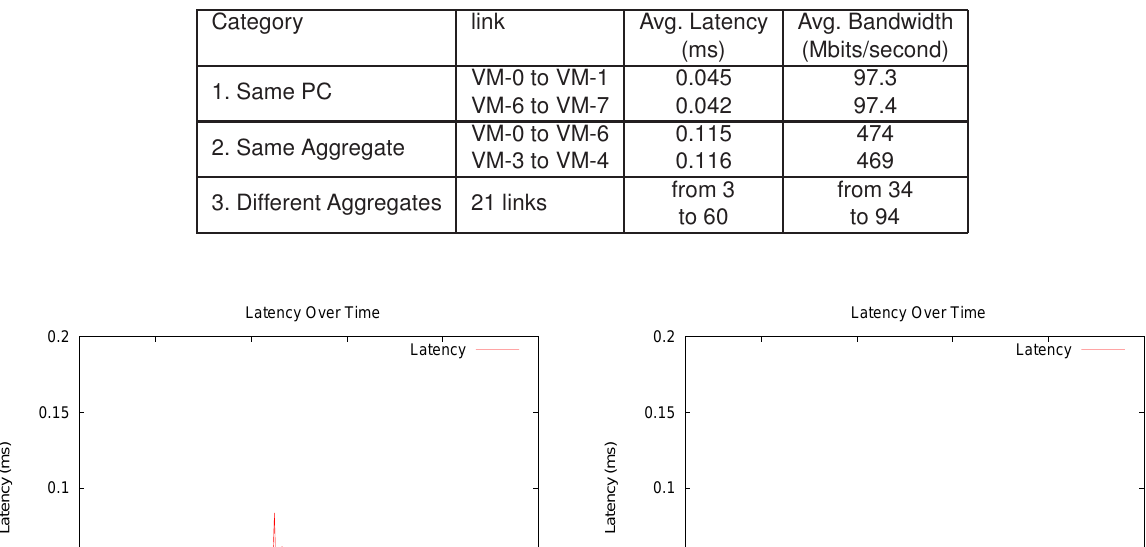
Table 1. Average latency and bandwidth